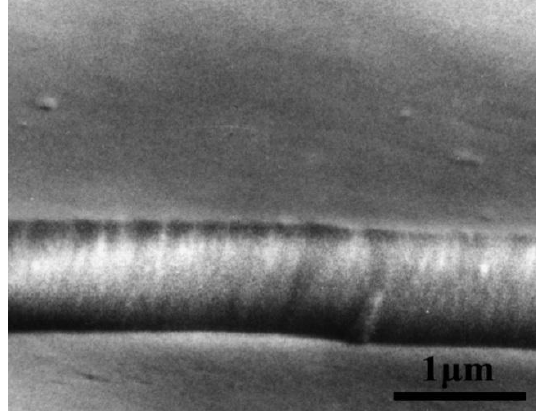
Figure 3. SEM profile of an as-deposited layer with a thickness of 1000